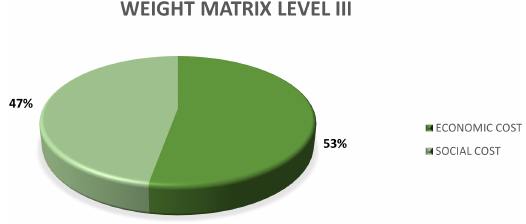
Figure 4: Weights level III